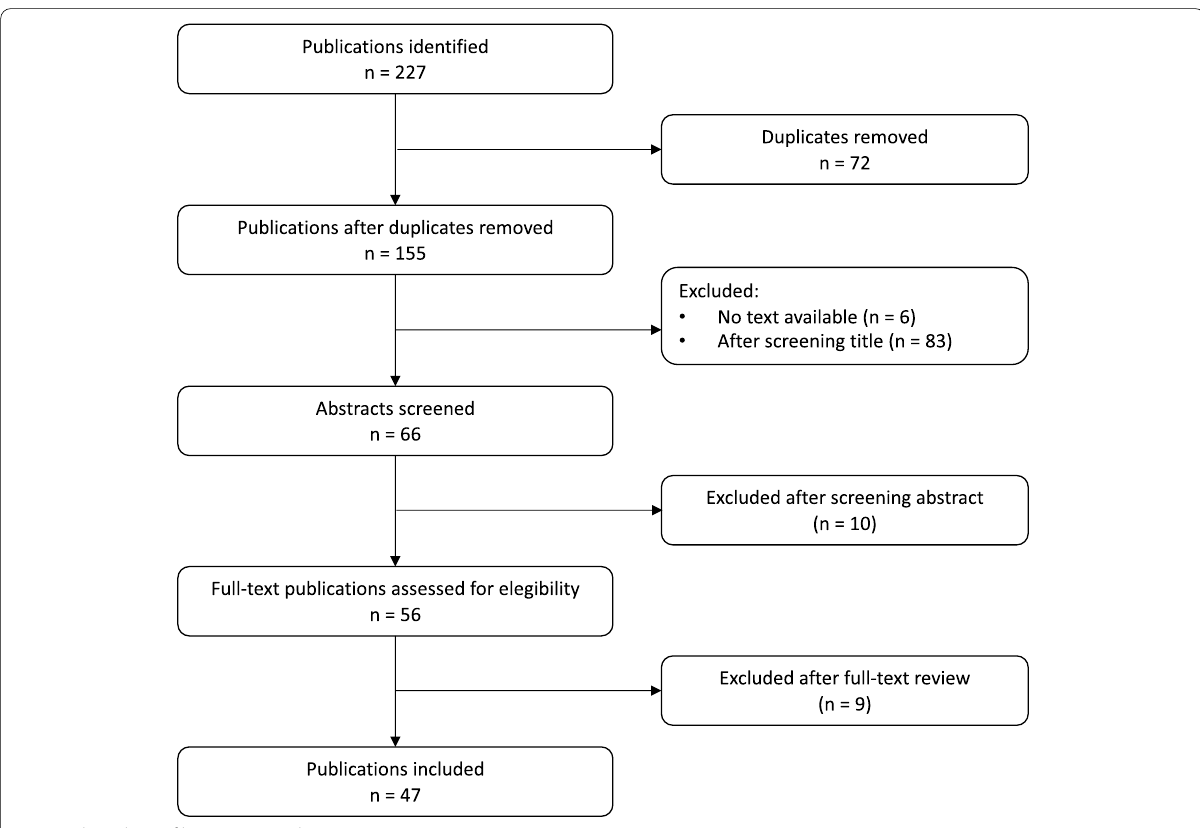
Fig. 1 Flow chart of literature